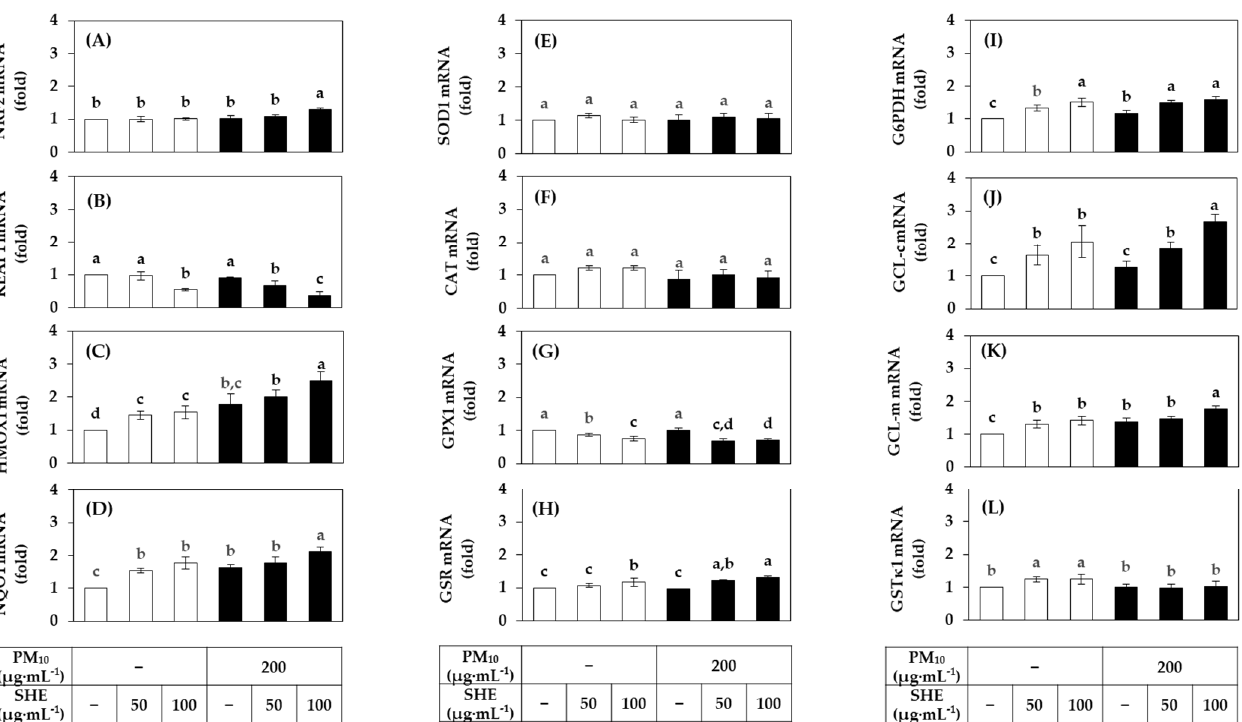
Figure 5. Effects of SHE on the mRNA expression levels of the defense genes in HaCaT keratinocytes under basal and PM 10 -exposed conditions. Cells were treated with SHE at different concentrations and cultured in the absence or presence of PM 10 (200 μ g mL − 1 ) for 24 h. The mRNA levels of nuclear factor erythroid 2-related factor (NRF) 2 ( A ), kelch-like ECH-associated protein (KEAP) 1 ( B ), heme oxygenase (HMOX) 1 ( C ), NAD(P)H quinone oxidoreductase (NQO) 1 ( D ), superoxide dismutase (SOD) 1 ( E ), catalase (CAT) ( F ), glutathione peroxidase (GPX) 1 ( G ), glutathione disulfide reductase (GSR) ( H ), glucose 6-phosphate dehydrogenase (G6PDH) ( I ), glutamate-cysteine ligase catalytic subunit (GCL-c) ( J ), glutamate-cysteine ligase modifier subunit (GCL-m) ( K ), and glutathione S-transferase (GST) κ 1 ( L ) were determined by quantitative real time-polymerase chain reaction (qRT-PCR) and normalized to that of glyceraldehyde 3-phosphate dehydrogenase (GAPDH). Data are presented as mean ± SD ( n = 3). Duncan’s multiple range test was performed to compare all group means to each other. Groups that share the same letters (a, b, c, or d) do not have significantly different means at the p < 0.05 level.